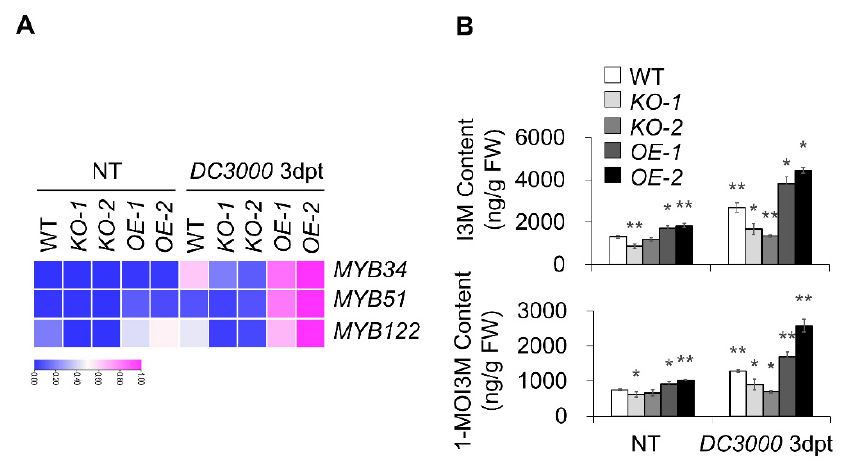
Figure 7. Indolic GS contributed to bacteria resistance of MACP2-OE . ( A ) Heatmaps show the fold change of key regulators in GS biosynthesis, containing MYB34 , MYB51 , and MYB122 in wild-type, MACP2-KO mutants, and MACP2-OEs plants after Pst DC3000 infection. The transcriptional profiles of relative gene expression values were analyzed using the TB tools. ( B ) Indolic GS contents of wild-type, MACP2-KO mutants, and MACP2-OEs plants after Pst DC3000 infection. The contents of indolic GS were measured by LC-MS. The experiments were biologically repeated three times with similar results. Error bars represent SD. n = 3 biological replicates. Asterisks indicate significant differences from the wild-type. * p < 0.05, ** p < 0.01 by Student’s t test.